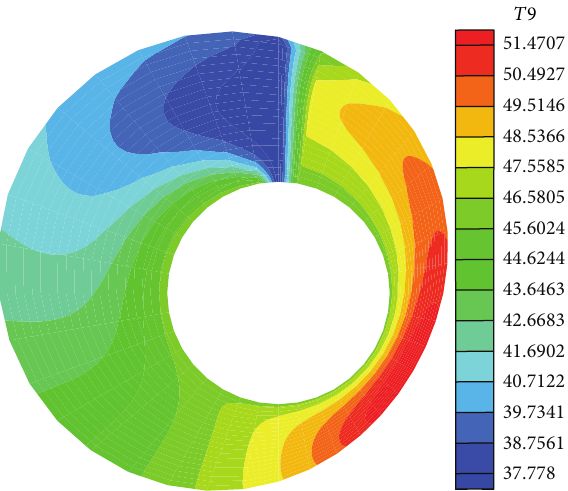
Figure 10: Isothermal lines of the journal bearing at its central plan for 𝜀 = 0.3 and 𝑛 = 0.9